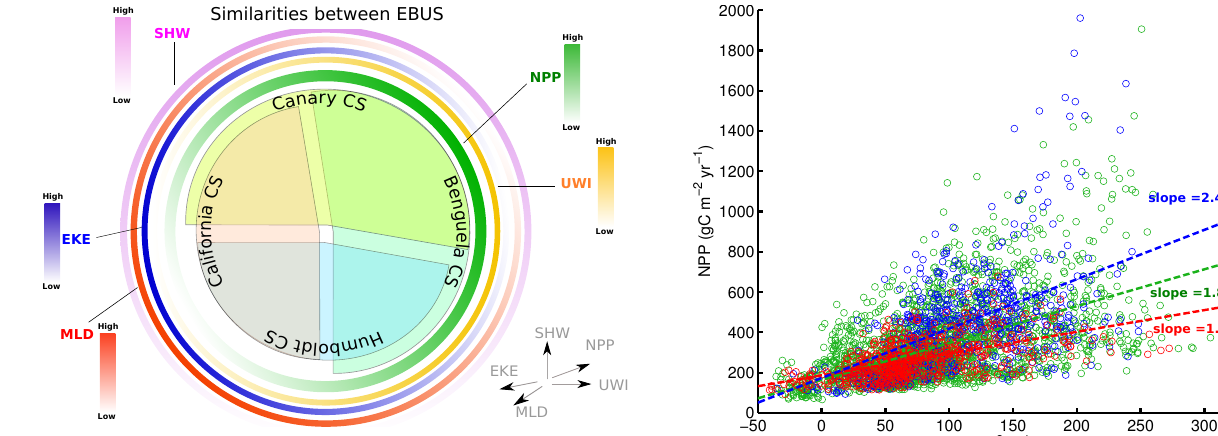
Fig. 13. The relationship between NPP and upwelling index (UWI) for strongly inhibited conditions (red circles), weakly inhibited con- ditions (blue circles), and intermediate conditions (green circles). The dashed lines show the corresponding linear regression